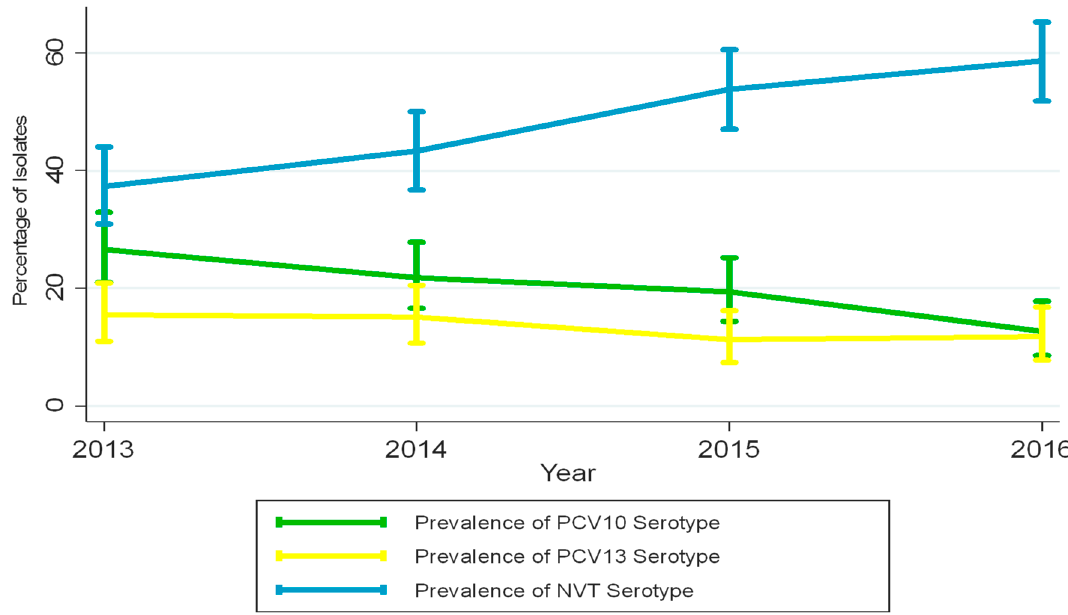
Figure 1. Proportion of children carrying PCV10, PCV13, and NVT serotypes over time. Rates for 2013 are from a previously published survey in the same community by the same group of authors.